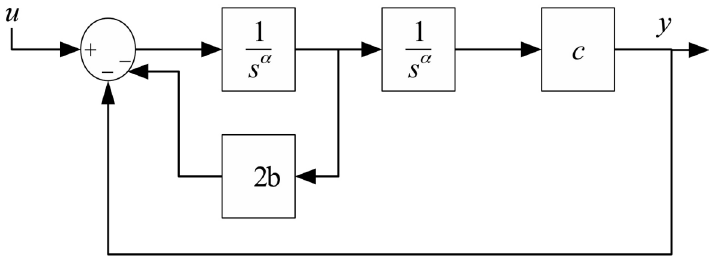
Figure 1. Bi-Fractional Filter realization